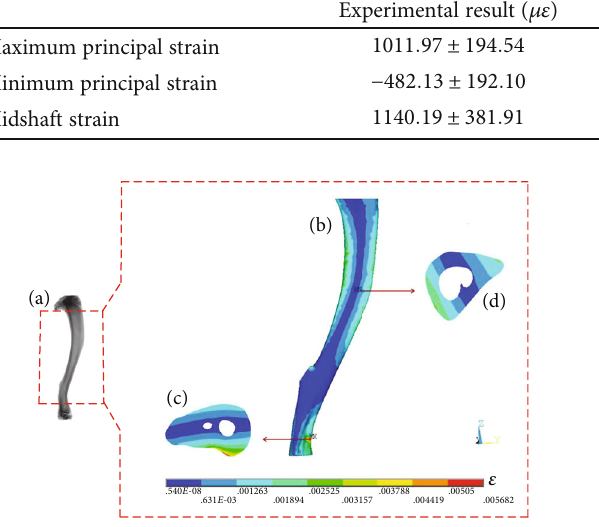
Figure 11: Typical von Mises elastic strain distribution of the tibial midshaft: (a) image of the tibia scanned by micro-CT; (b) von Mises elastic strain distribution of the tibial midshaft; (c) the cross section with the maximal strain; (d) the cross section with the minimal strain; red dotted box: the tibial midshaft selected for analyzing the strain